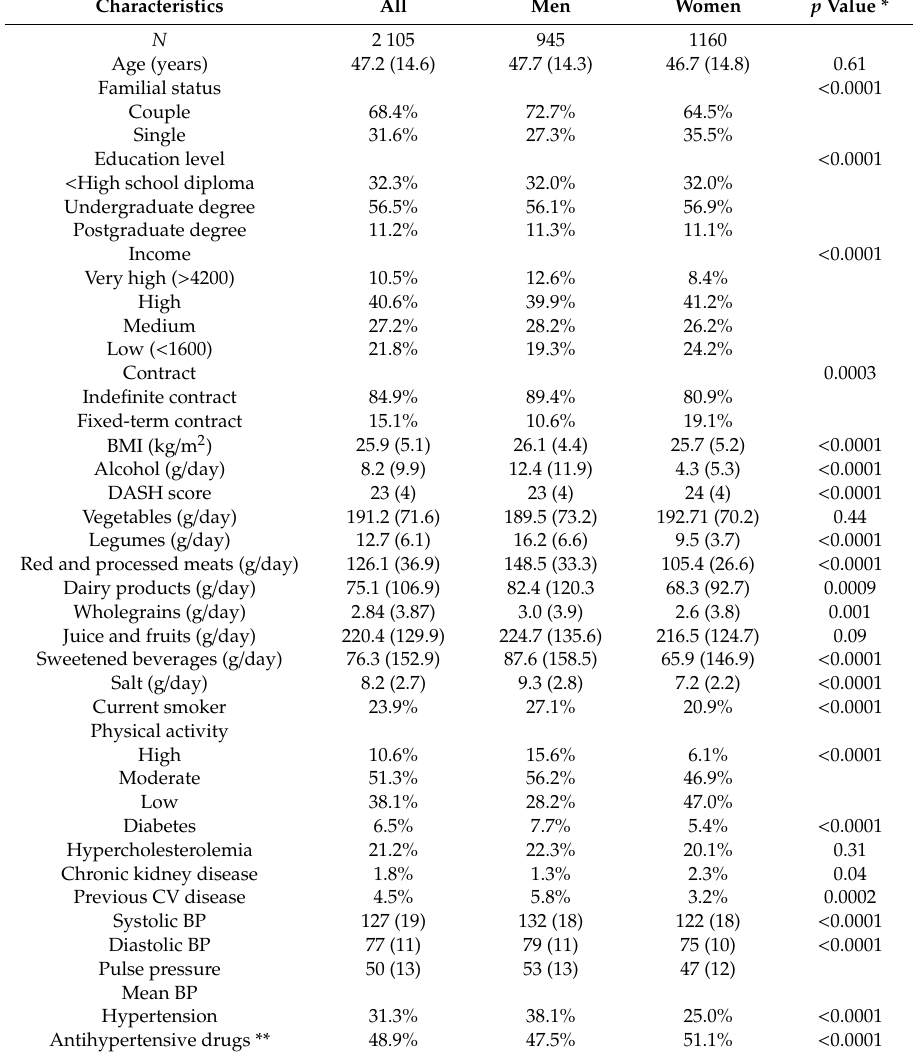
Table 1. Characteristics of the study population, Esteban survey 2014–2016.